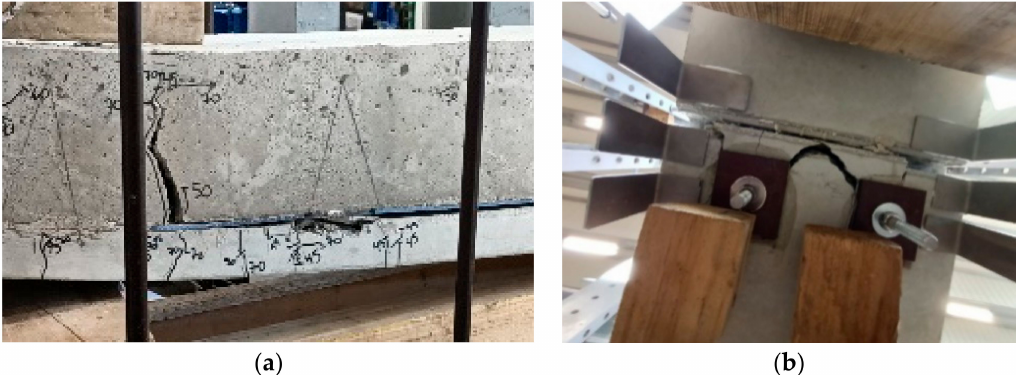
Figure 11. Observations from test C06: ( a ) typical crack pattern with formation of an overlap block and pull-out of the lattice girder before the end of the overlap reinforcement; ( b ) lower face of